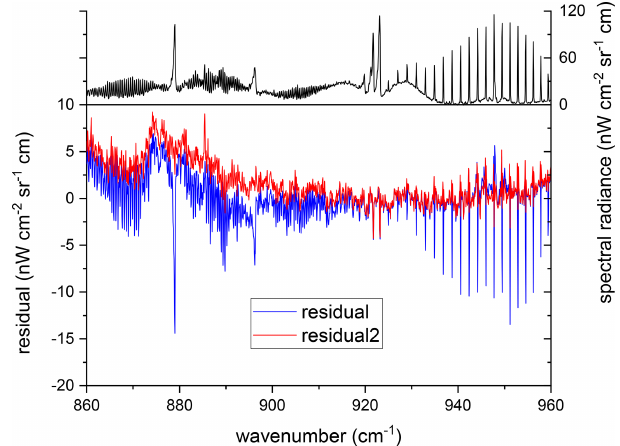
Figure A3. Residuals in the spectral range of 860–960cm − 1 after the broadband fit (blue) and after fitting selected gases in individual microwindows (red). The upper panel shows the measured spectrum on the right ordinate, reduced by a factor of 12. The spectral signa- tures of HNO 3 and CO 2 are clearly reduced after the second fit, as is that of SF 6 around 948cm − 1